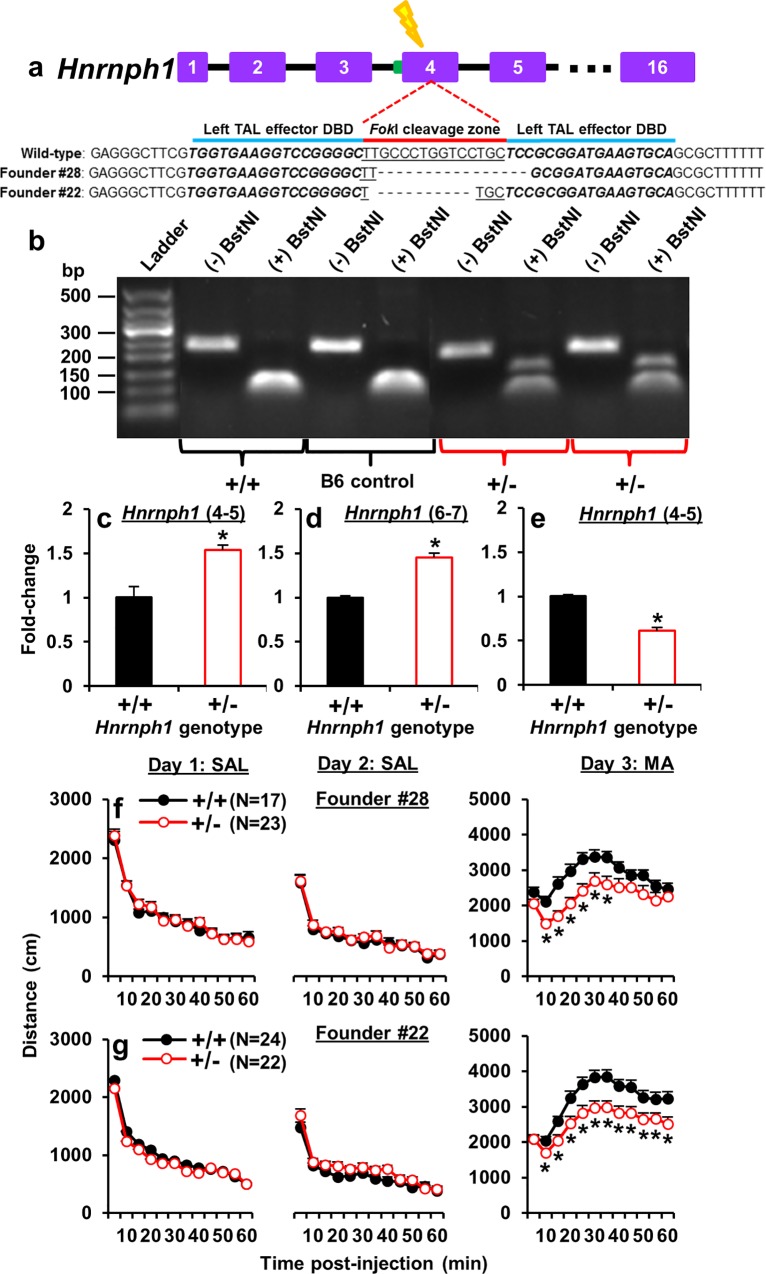
TALENS-targeted frameshift deletions in Hnrnph1 +/- mice reveal Hnrnph1 as a quantitative trait gene for MA sensitivity.
(a): Left TAL effector (50,191,867–50,191,883 bp) and right TAL effector (50,191,899–50,191,915 bp) separated by the FokI cleavage zone were used to introduce frameshift deletions in the first coding exon of Hnrnph1 (exon 4) that resulted in premature stop codons (S8 Fig). Founder #28 contained a 16 bp deletion and Founder #22 contained an 11 bp deletion. (b): A PCR amplicon capturing the FokI cleavage zone was digested with BstNI. Hnrnph1
+/+ mice contained two copies of a functional BstNI restriction site and thus, restriction digest produced a single band containing digested fragments of equal size. Hnrnph1
+/- mice were heterozygous for a deletion of the BstNI site and showed both the digested band and a larger, undigested band. Gel band lanes were cropped and re-ordered to present wild-type first (+/+) followed by B6 control, and heterozygous samples (+/-). (c): There was a significant upregulation of total Hnrnph1 transcript levels in Hnrnph1
+/- mice as indicated by cDNA amplification using qPCR primers spanning exons 4–5 that hybridized to both genotypes (t6 = 5.69; p = 0.0013). (d): An upregulation of total Hnrnph1 transcript levels was also indicated by cDNA amplification using qPCR primers spanning untargeted exons 6–7 (t6 = 8.53; p = 0.00014). (e): A significant downregulation of the Hnrnph1
+/+ transcript levels was observed in Hnrnph1
+/- mice that was indicated by cDNA amplification using primers spanning exons 4–5, one of which hybridized to the deleted Hnrnph1
+/+ sequence (t6 = 9.45; p = 0.00091; Fig 5e). *p < 0.05. (f): In Line #28, there was no effect of genotype on locomotor activity in response to saline (SAL) on Days 1 or 2 (left, middle panels). On Day 3, Hnrnph1
+/- mice from Line #28 heterozygotes showed a significant reduction in MA-induced locomotor activity compared to Hnrnph1
+/+ littermates (right panel). (g): In Line #22, there was no effect of genotype on locomotor activity in response to SAL on Days 1 or 2 (left, middle panels). On Day 3, Hnrnph1
+/- mice from Line #22 showed significantly reduced MA-induced locomotor activity compared to Hnrnph1
+/+ littermates. Data are presented as the mean ± S.E.M. * = significant genotype x time interaction followed by unpaired t-tests of individual time bins (p < 0.05; S3 Table; S1 Text; Supplementary Information).